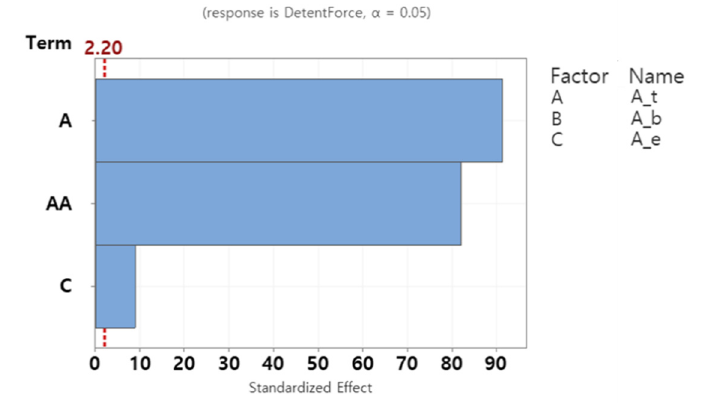
Figure 16. Pareto chart for end effect detent force.